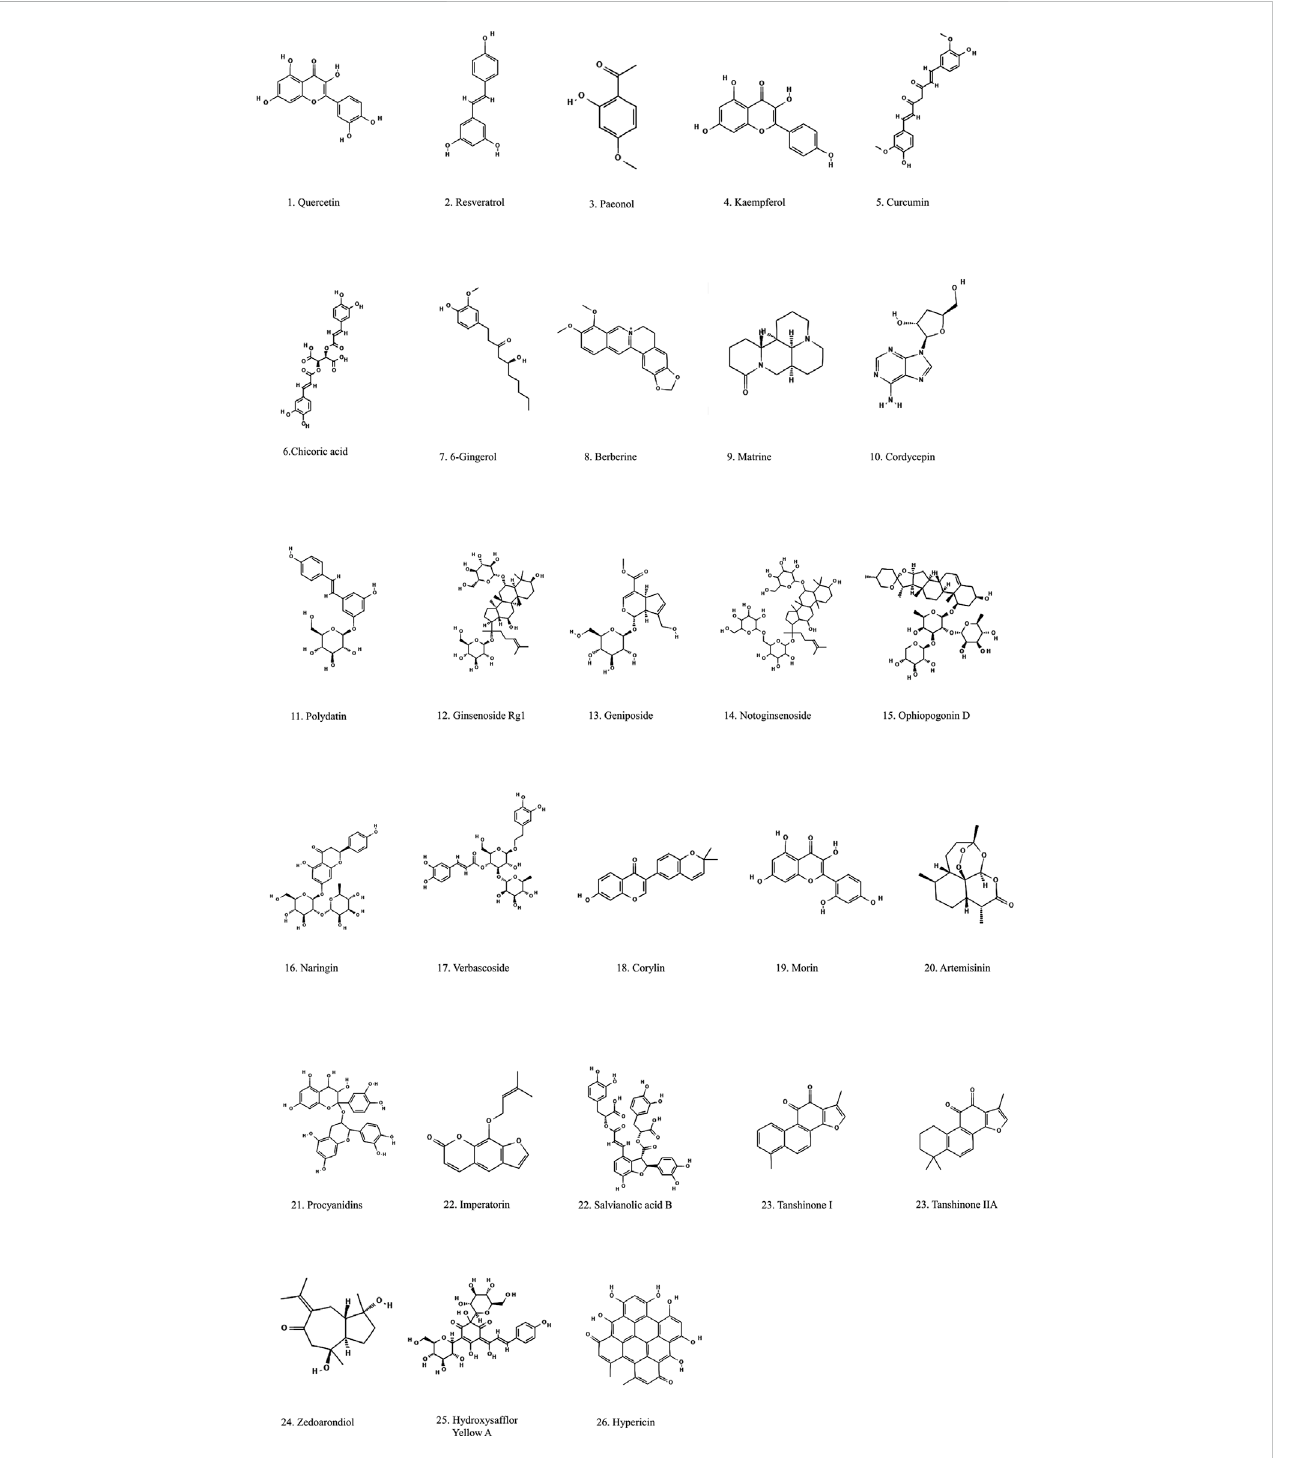
FIGURE 4 Structural formulation of natural compounds derived from botanical drugs with anti-atherogenic effects.